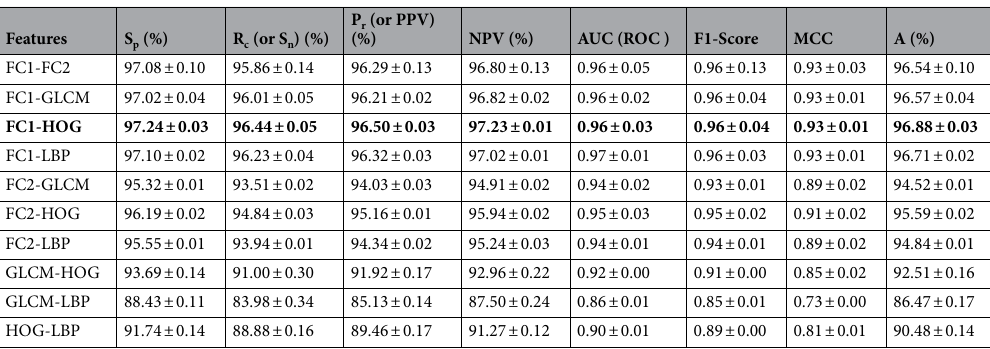
Table 15. Sensitivity analysis manifold combinations of two features using a 1-NN classifier and BraTS-2021 dataset with RA. Significant values are given in bold.